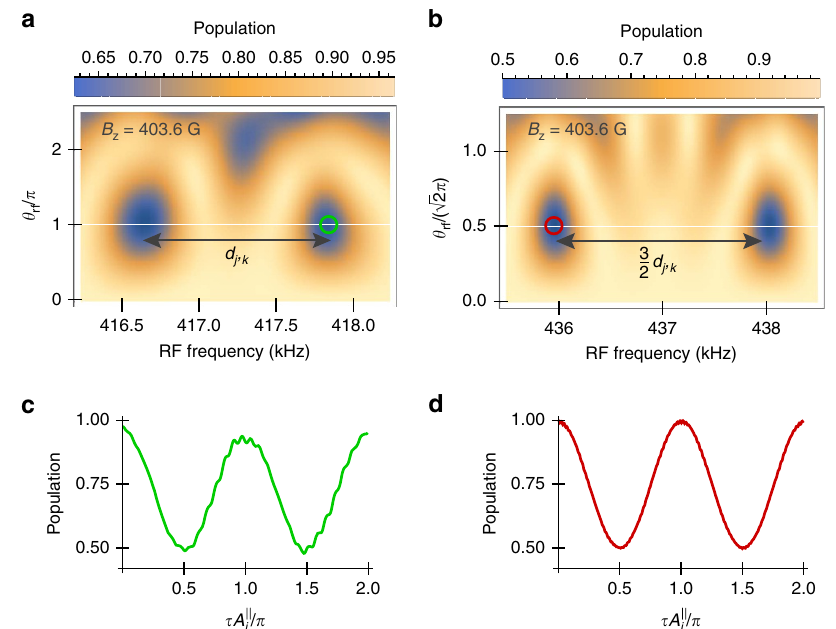
Figure 5 | Population signal of coupled spin pairs. ( a ) Signal patterns of a type-h 13 C spin pair in a C–C bond E 1.0nm away from the NVcentre, using the interaction time t ¼ 10 m s and length of RF driving t rf E 2ms. The dipolar coupling strength d j , k E 2 p (cid:10) 1.37kHz. The hyperfine components of the two spins A jj 2 p (cid:10) 15 : 6kHz and A jj 2 p (cid:10) 22 : 5kHz. ( b ) Same as a but for a type-d pair located E 1.55nm away from the NV centre and t ¼ 50 m s, and the j (cid:8) k (cid:8) hyperfine components of the two spins A jj 2 p (cid:10) 5 : 00kHz and A jj 2 p (cid:10) 4 : 96kHz have similar strengths. The parameters used in c , d are j (cid:8) (cid:3) k (cid:8) (cid:3) indicated by the circles in a , b , jj d (cid:3) A jj between the hyperfine components 34 . A spin pair j ; k ¼ A j k